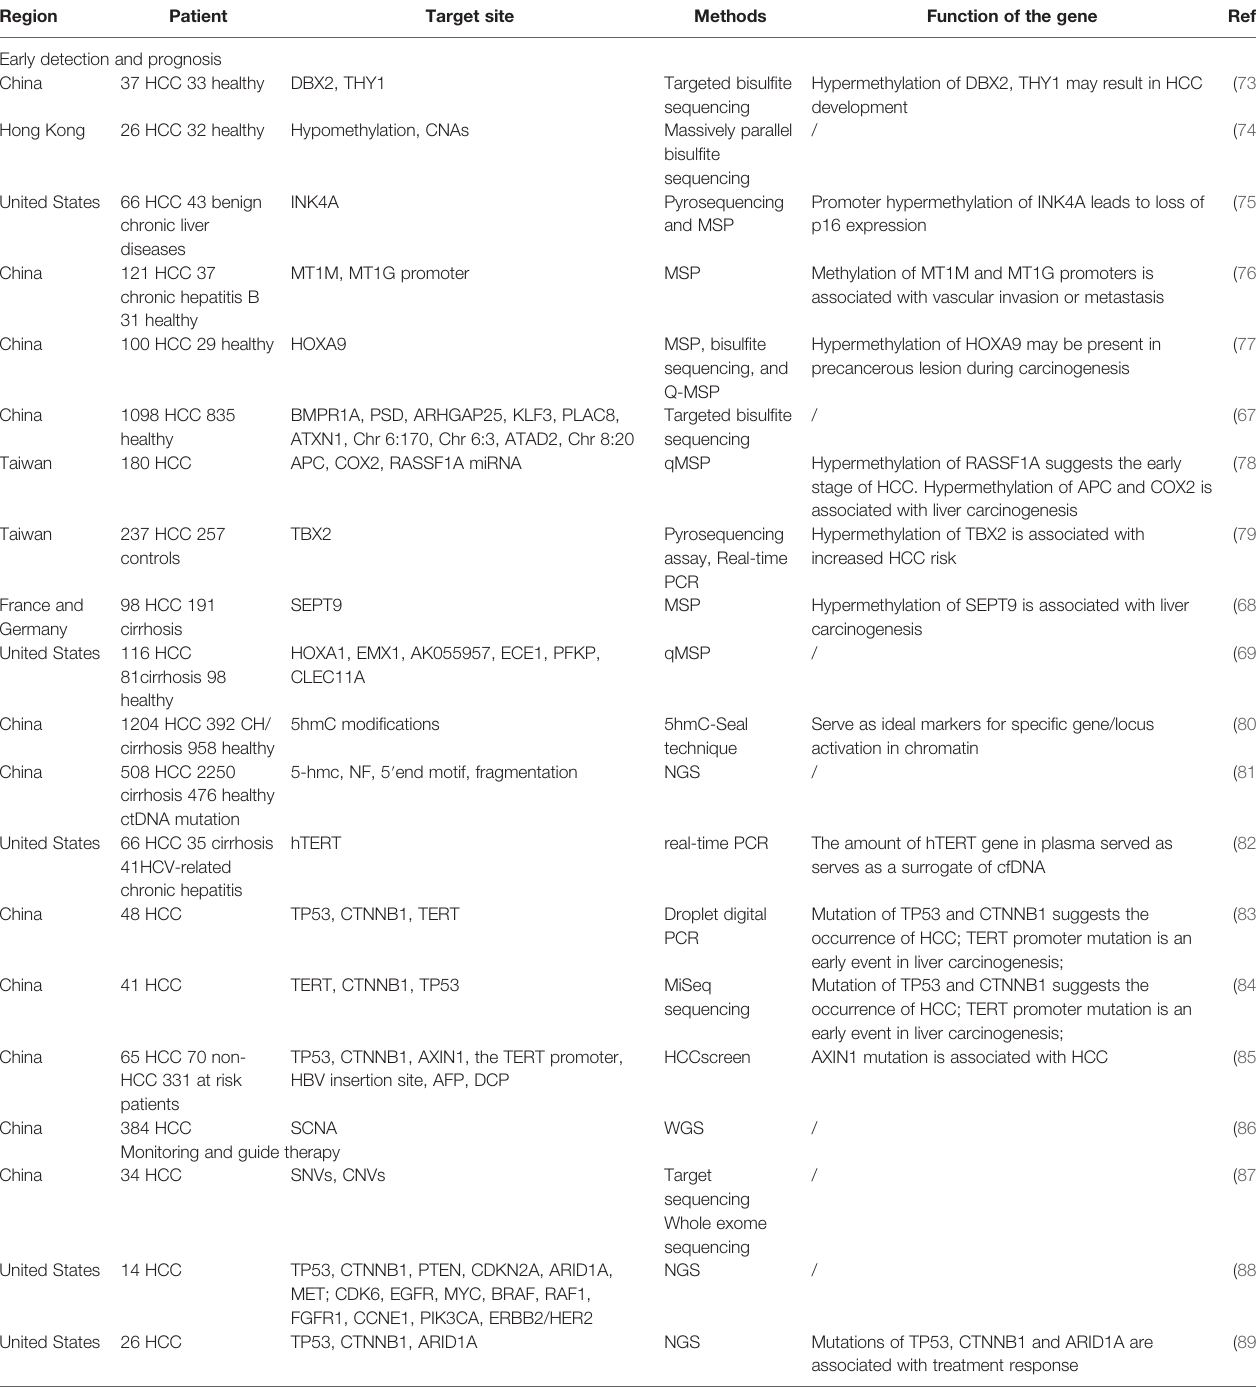
TABLE 2 | Clinical applications of ctDNA in